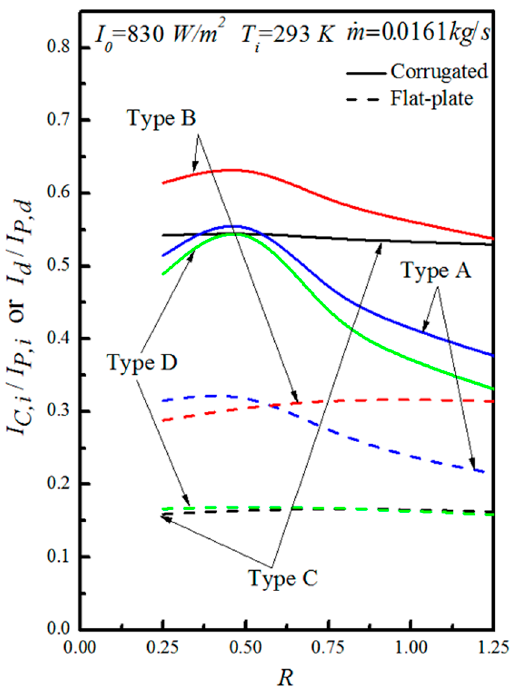
Figure 14. The ratio of the collector efficiency improvements and power consumption increments ( ṁ = 0.0161 kg/s).